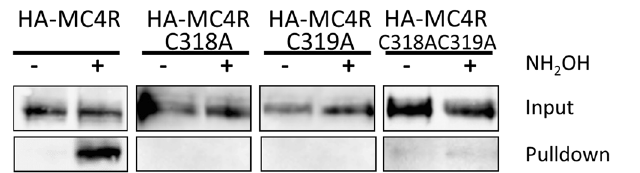
Figure 4. S-acylation assay of MC4R. HA-tagged wild-type (WT) MC4R, HA-MC4R(C318A), HA- MC4R(C319A) and HA-MC4R(C318AC319A) were pulled down and assessed for presence of acyl chains. WT MC4R was observed in the pulldown while the alanine mutants, to eliminate putative acyl-modification sites, were not, indicating not only acylation of MC4R but also the location of acylation. Paired pulldown of NH 2 OH- treated and -untreated samples for each mutant are run side-by-side (marked by black borders). Blot shown is representative of 3 similar